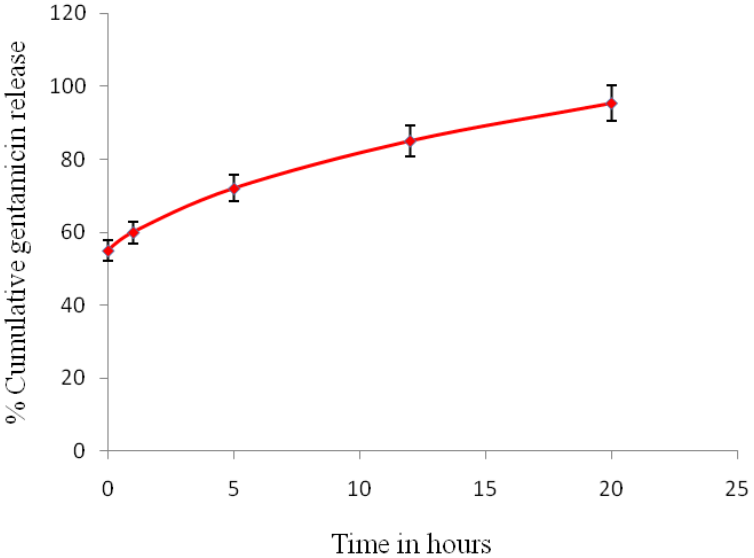
Figure 10. In vitro gentamicin release profile from P(3HB) microspheres in SBF (sample